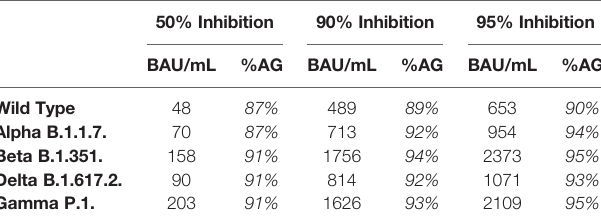
TABLE 3 | Calculated IgG anti-S titer corresponding to 50%, 90% and 95% inhibition and % agreement (%AG, above below cut-off for antibody titer and % inhibition) for the different strains.